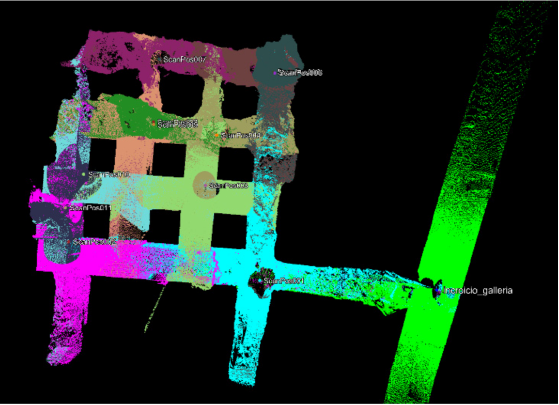
Figure 5. Top view of the infirmary from 3D point cloud. S from 1 to 4 are the scanning